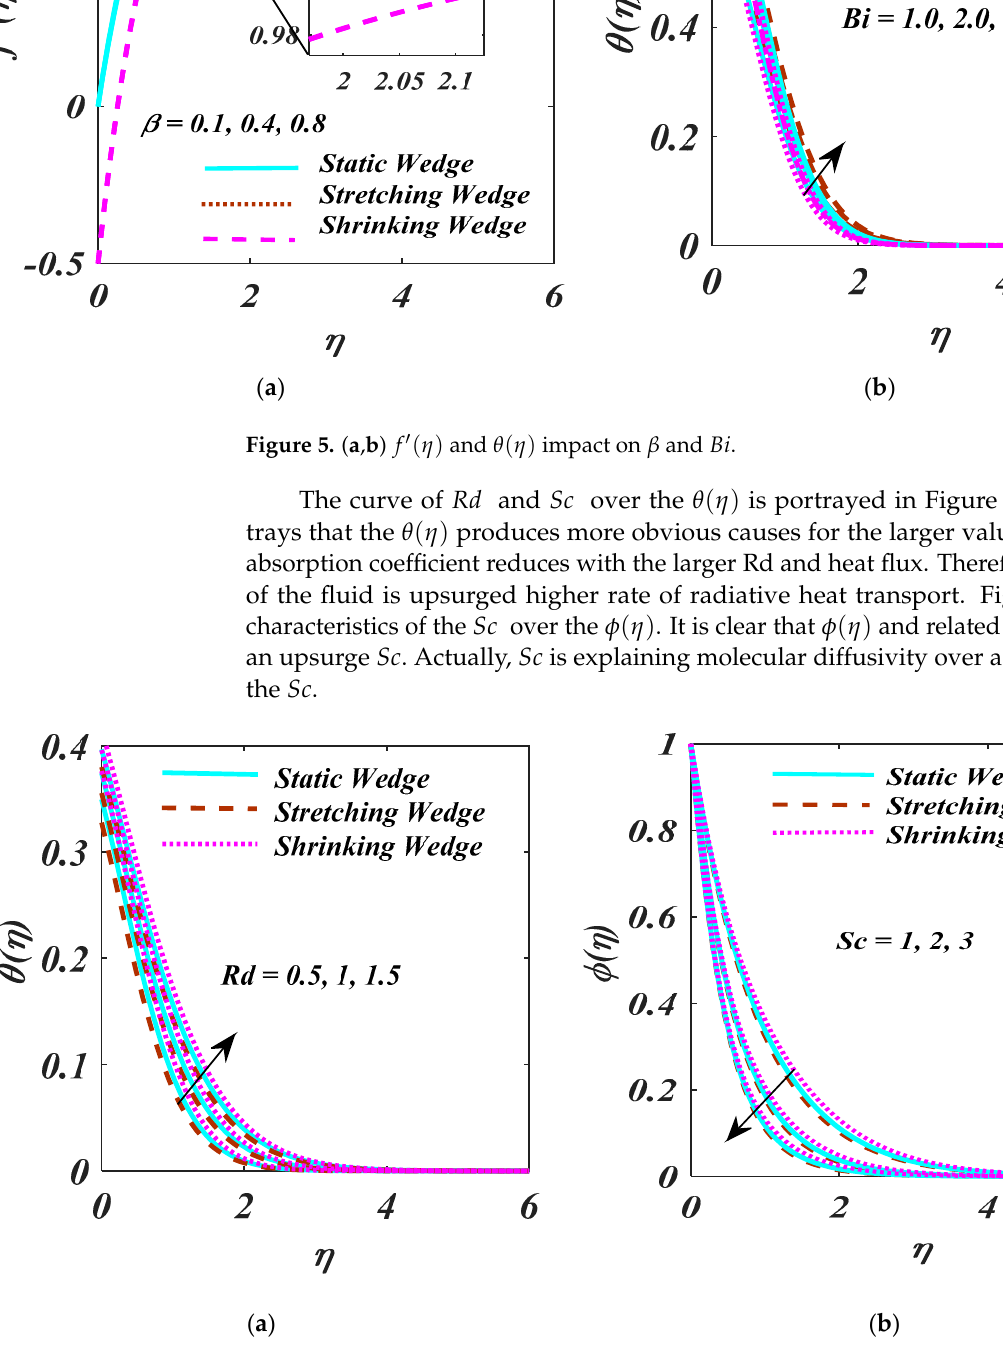
Figure 6. ( a , b ) (cid:2016)(cid:4666)(cid:2015)(cid:4667) and (cid:2038)(cid:4666)(cid:2015)(cid:4667) on (cid:1844)(cid:1856) and (cid:1845)(cid:1855) . Figure 6. ( a , b ) θ ( η ) and φ ( η ) on Rd and Sc